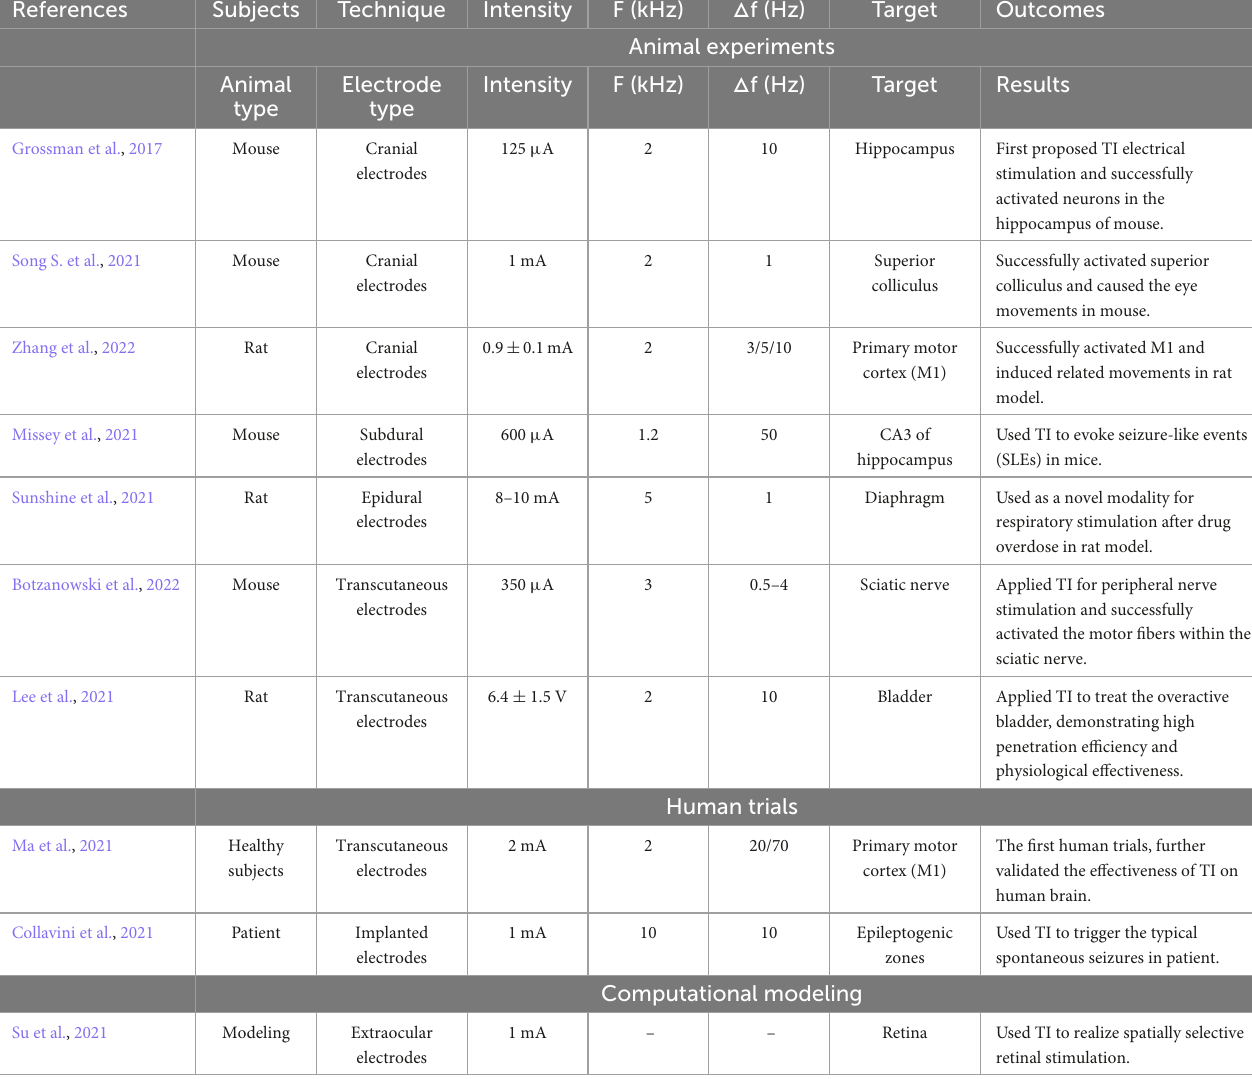
TABLE 1 The developments and applications of temporally interfering (TI) electrical